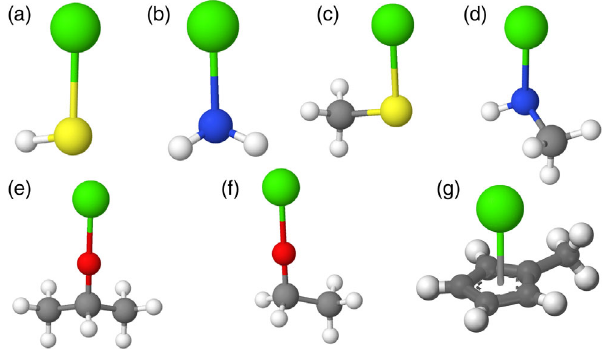
FIG. 2. Model geometries for several of the species proposed in this work. (a) MSH, (b) MNH 2 , (c) MSCH 3 , (d) MNHCH 3 , (e) MOCH ð CH 3 Þ 2 , (f) MOC 2 H 5 , and (g) MC 5 H 4 CH 3 , where M represents an alkaline-earth metal atom. Atomic species are colored as follows: Green is for alkaline-earth metal, yellow is for sulfur, blue is for nitrogen, red is for oxygen, gray is for carbon, and white is for hydrogen. Structures were generated using MolView